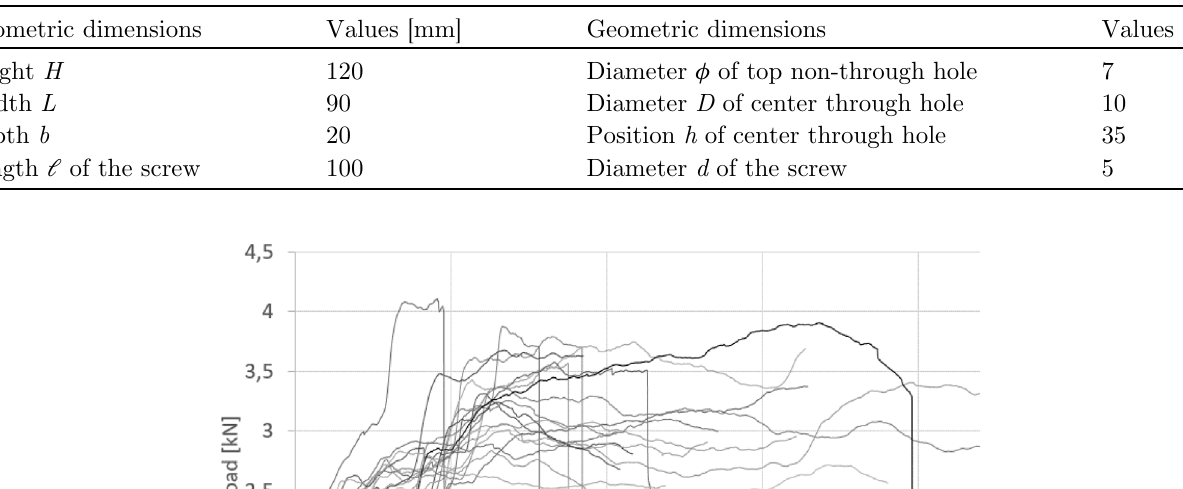
Table 2. – Geometric dimensions of the samples, screw and nut.